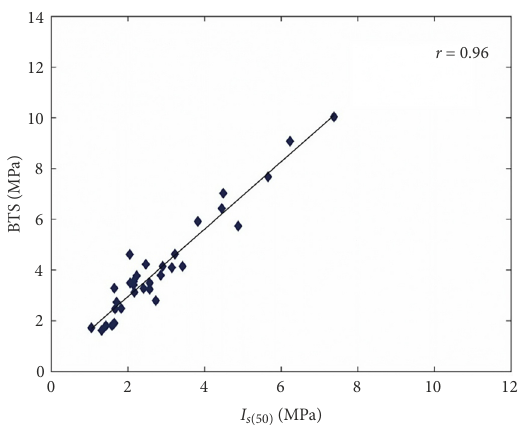
Figure 12. Brazilian tensile strength (BTS) versus point load